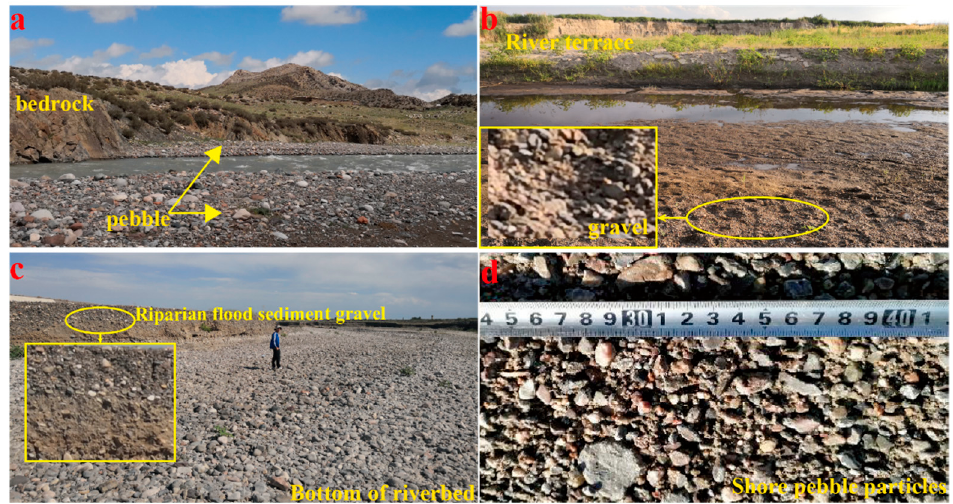
Figure 14. Photos of representative rivers in the study area. ( a ) The river bank is composed of bedrock and large pebbles distributed on both sides of the river; ( b ) a river terrace is present and the floodplain is gravelly; ( c ) the river is dry during the dry season, and the river bottom is covered by pebbles; ( d ) pebble particles on the bank.